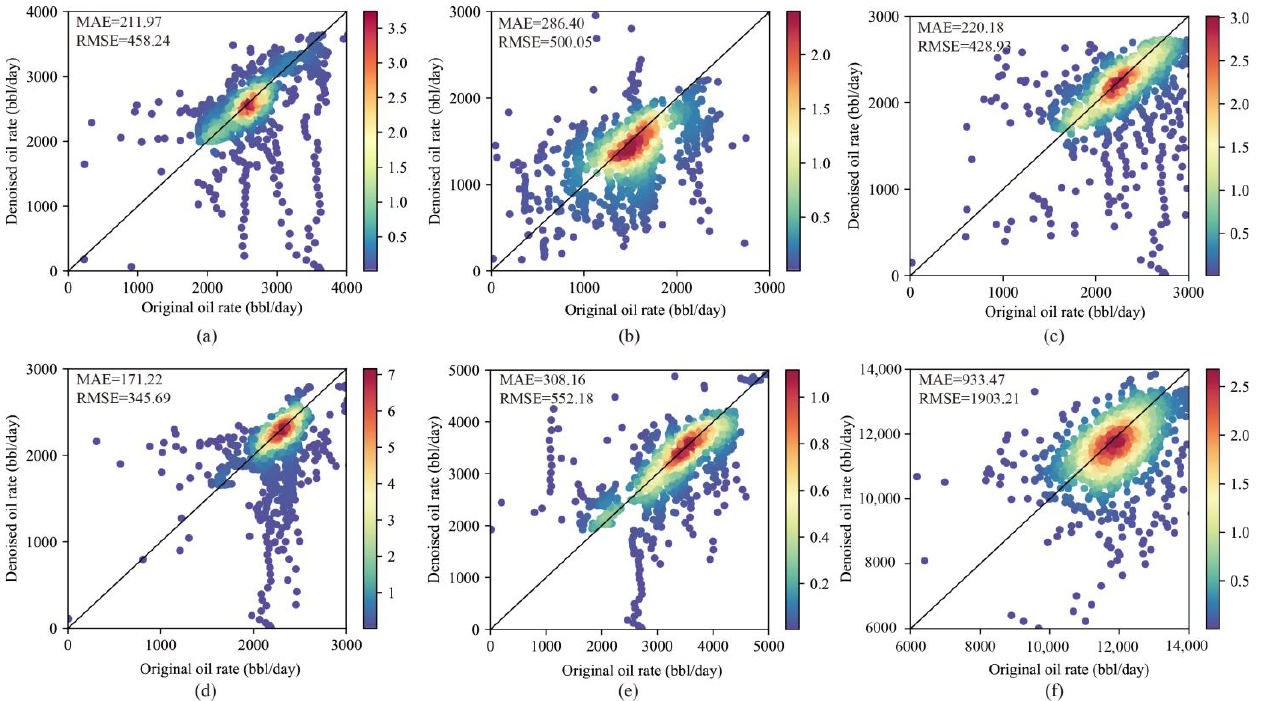
Figure 8. The performance of Kalman filter: ( a ) P1 well; ( b ) P2 well; ( c ) P3 well; ( d ) P4 well; ( e ) P5 well; ( f ) well pattern.